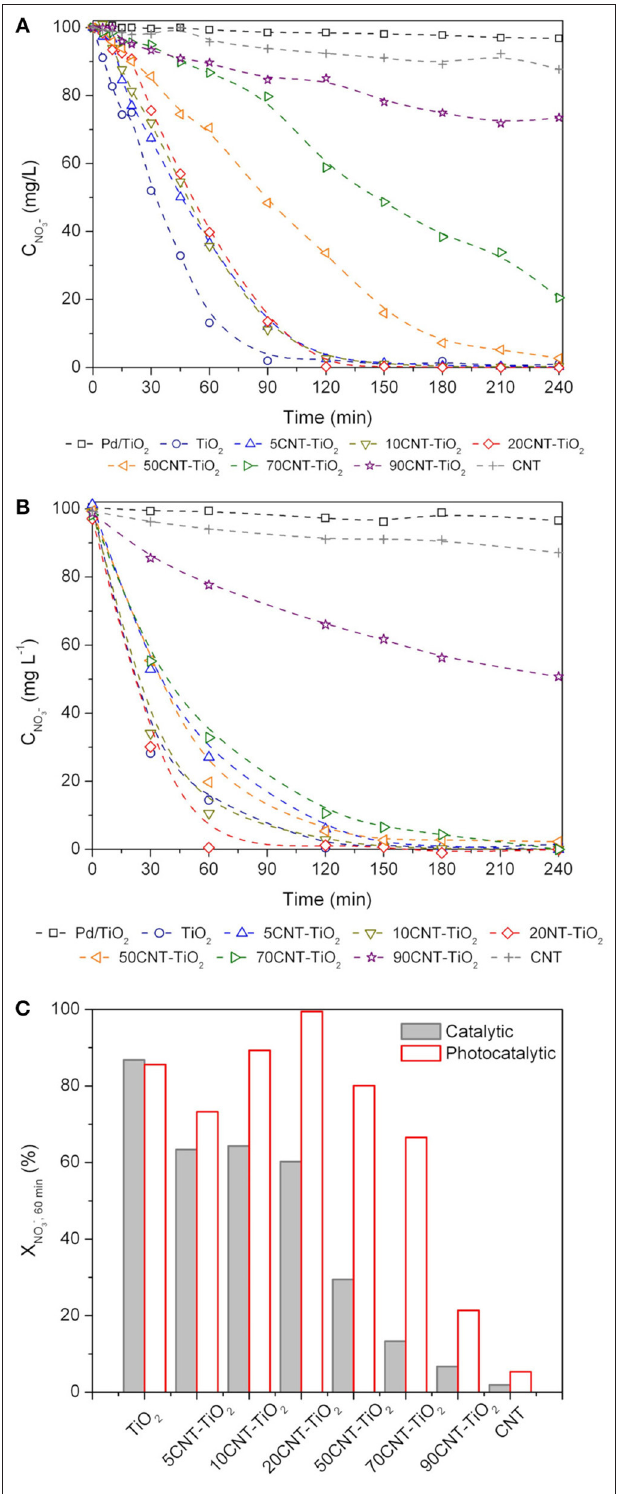
) during catalytic (A) and FIGURE 6 | Nitrate concentration ( C NO 3 − photocatalytic (B) reactions. Pd/TiO 2 refers to the monometallic catalyst while all other results refer to Pd-Cu bimetallic catalysts. Nitrate conversion at 60min ) using Pd-Cu loaded materials (C) ( X NO 3 − ,60 min